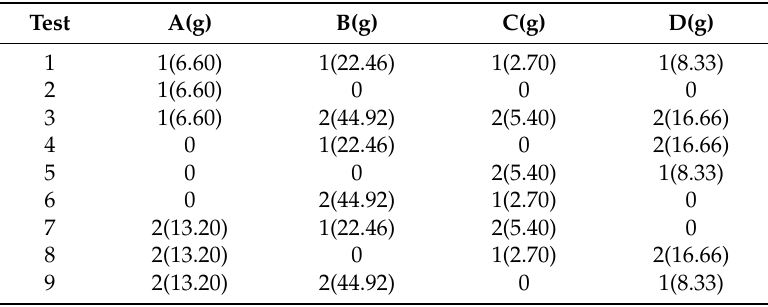
Table 3. Array of orthogonal compatibility